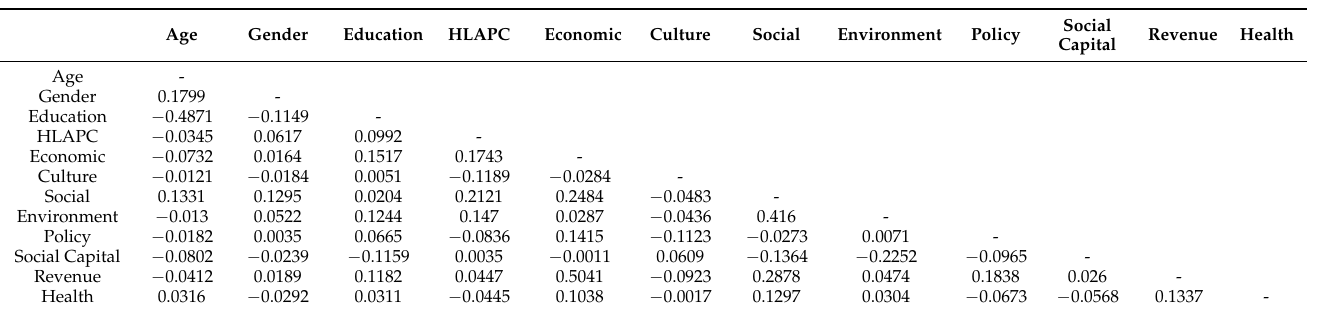
Table 3. Pearson correlation matrix for theoretical variables.